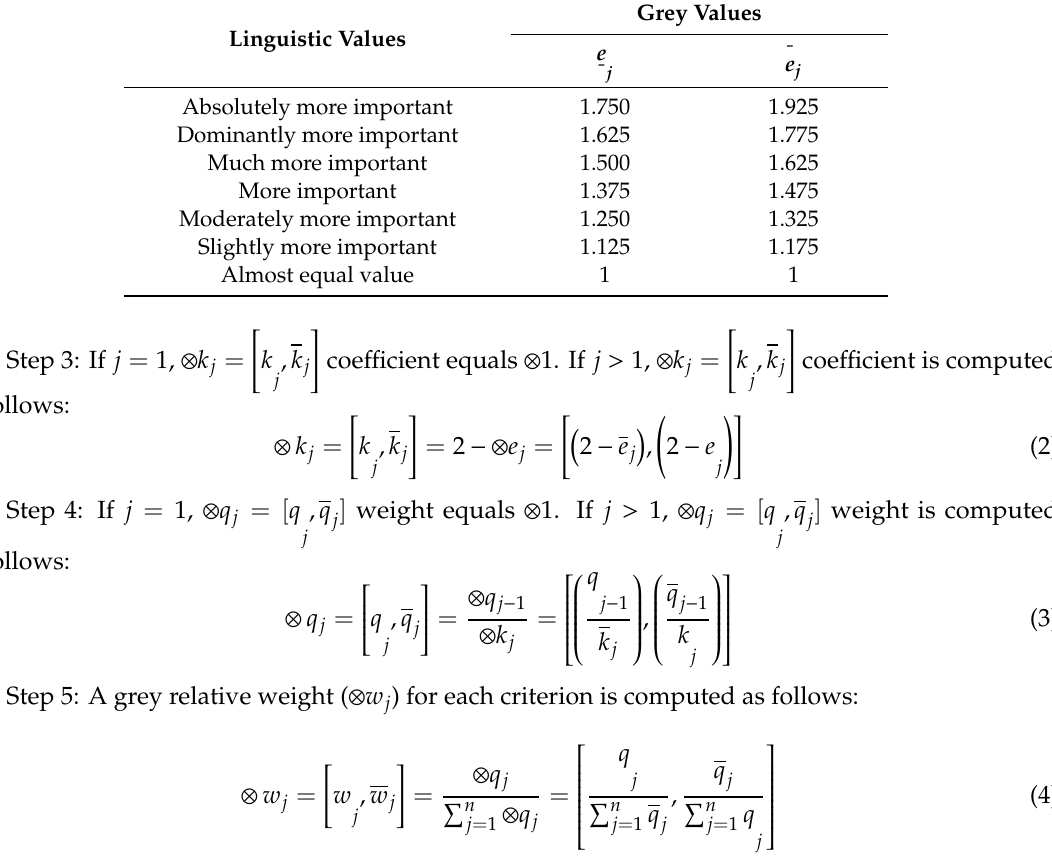
Grey Values ¯ e e j ¯ j